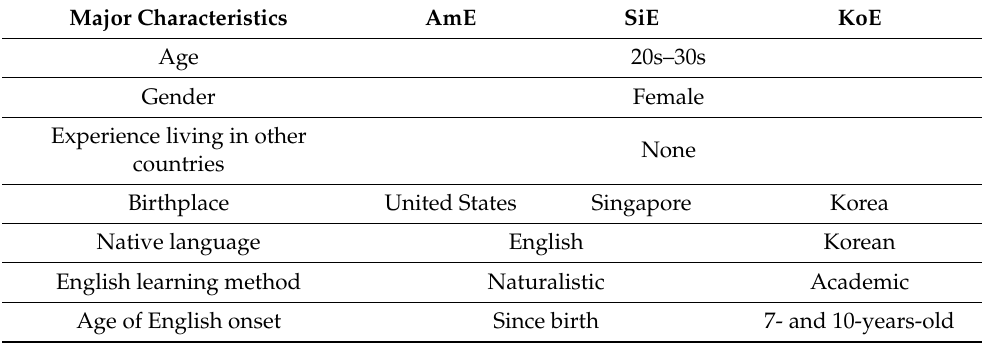
Table 1. Basic criteria of the selected